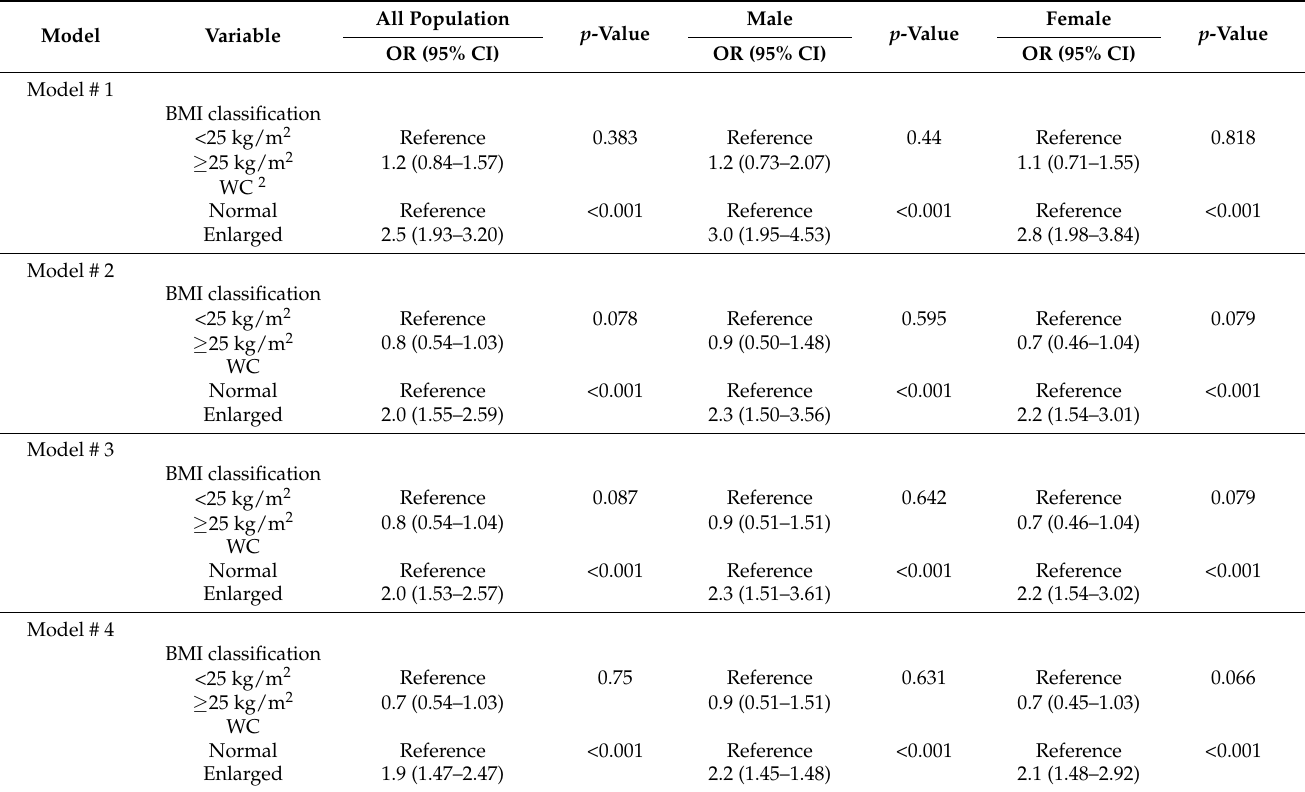
Table 6. Associations of BMI and WC with cardiovascular diseases (CVD) among the study population stratified by sex 1 .